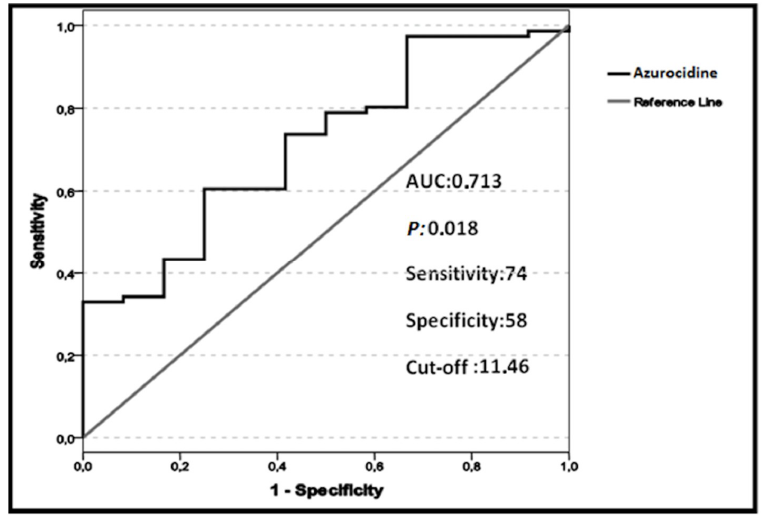
Figure 1. Receiver-operating characteristic (ROC) curve analysis demonstrating the cut-off value of azurocidin for the diagnosis of myocardial infarction (MI) using data from 76 patients with ST segment elevation myocardial infarction and 30 healthy control subjects. The cut-off level of >11.46 ng/mL had 74% sensitivity and 58% specificity in predicting MI (ROC area under the curve (AUC), 0.713; p = 0.018).